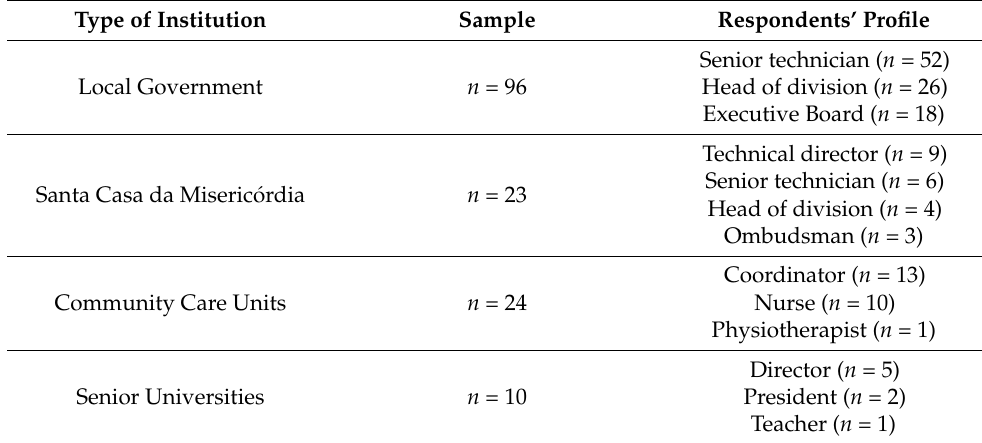
Table 1. Role/service they perform at their